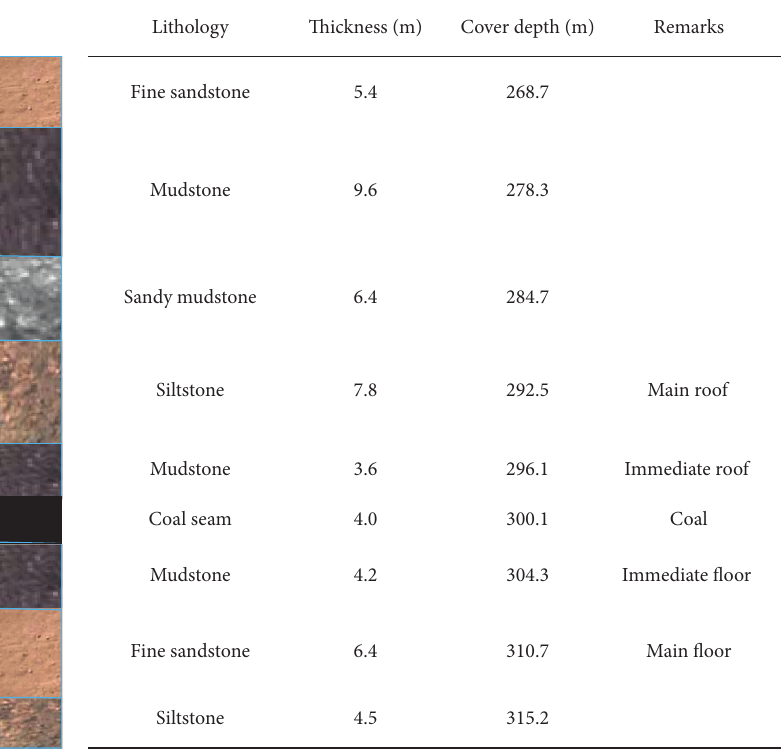
Figure 2: Detailed stratigraphic column for the test